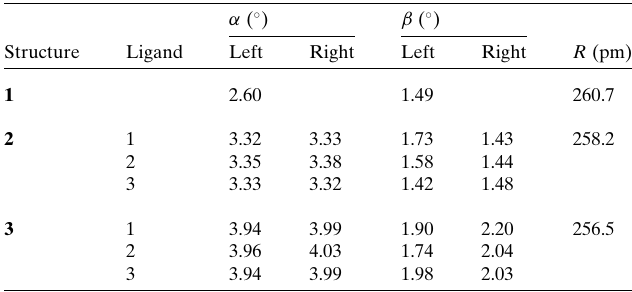
Table 1 Angles (cid:2) and (cid:3) as shown in Fig. 8 and bond length R for differently optimized structures. Structures were optimized using DFT with symmetry restrictions (structure 1 ), without symmetry restrictions (structure 2 ) and without symmetry restrictions and a solvation sphere (structure 3 ).